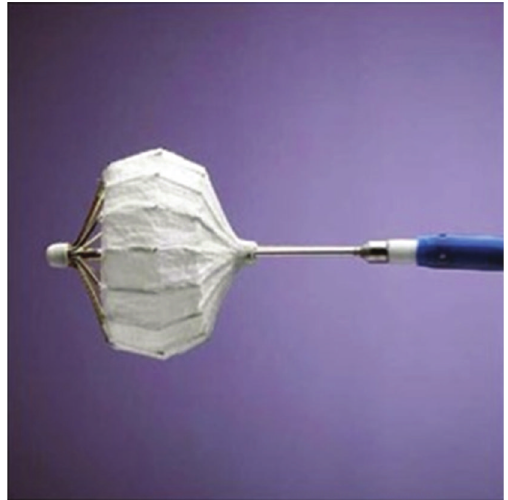
Figure 1: The PLAATO device shown mounted on its delivery catheter. ( Image courtesy of Nature Publishing Group. )